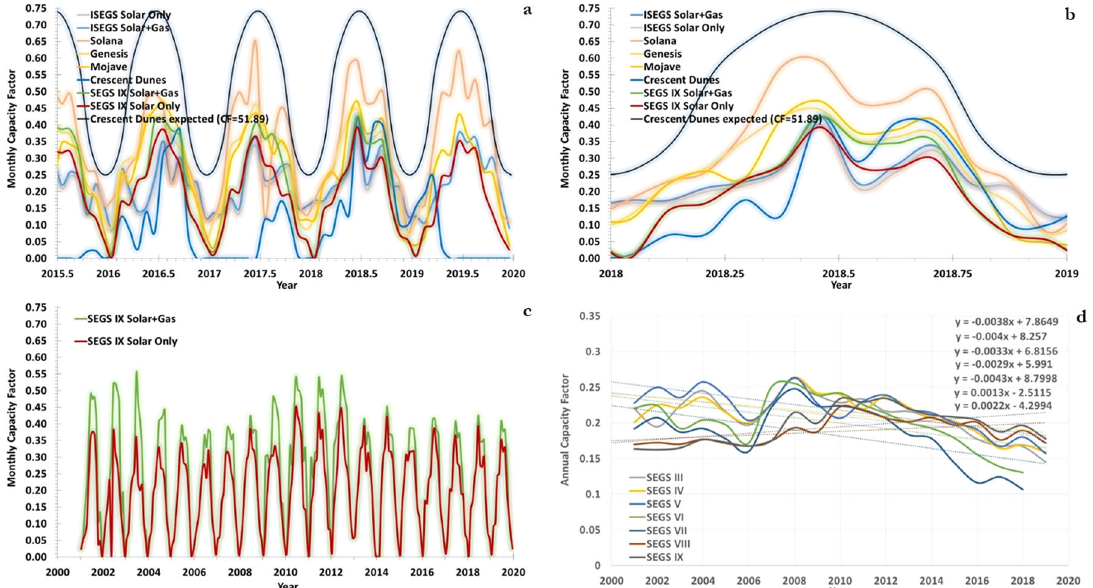
Fig. 3 Technical performances of existing CSP PT and ST plants with and without TES. a , b The monthly ε following seasonal irradiance variability of a CSP plant with molten salt TES delivering the annual average ε of 51.89% expected for Crescent Dunes, and the actual ε of the plants of Crescent Dunes CSP ST with 10 h molten salt TES, Genesis and Mojave CSP PT without any TES, Solana CSP PT with 6 h molten salt TES, ISEGS CSP PT without any TES but boosted by natural gas combustion, and SEGS IX, CSP PT without any TES but boosted by natural gas combustion over the last 3 years and the year 2018. The actual production data is from EIA (2019). c The data of the monthly ε of the plant SEGS IX since 2001. 2001 is the year the EIA statistics start, but this plant has been operational since 1990. This image shows the stable solar production of this design. d The data of SEGS III to SEGS IX since 2001 for the solar production depurated of the natural gas boost as proposed by the EIA.